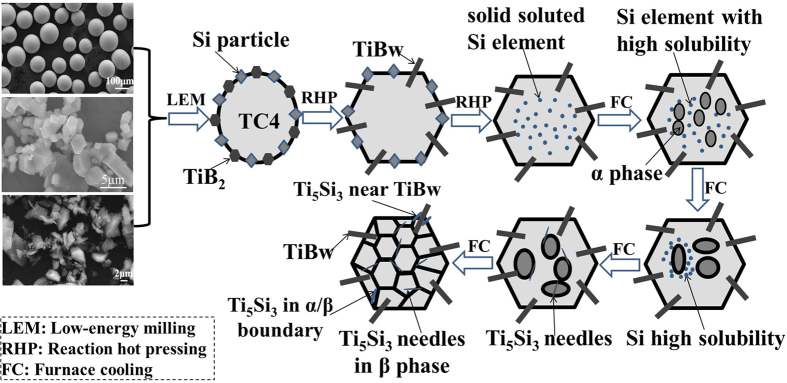
Schematic illustrations of the formation mechanism of Ti5Si3 needles and two-scale network distribution.